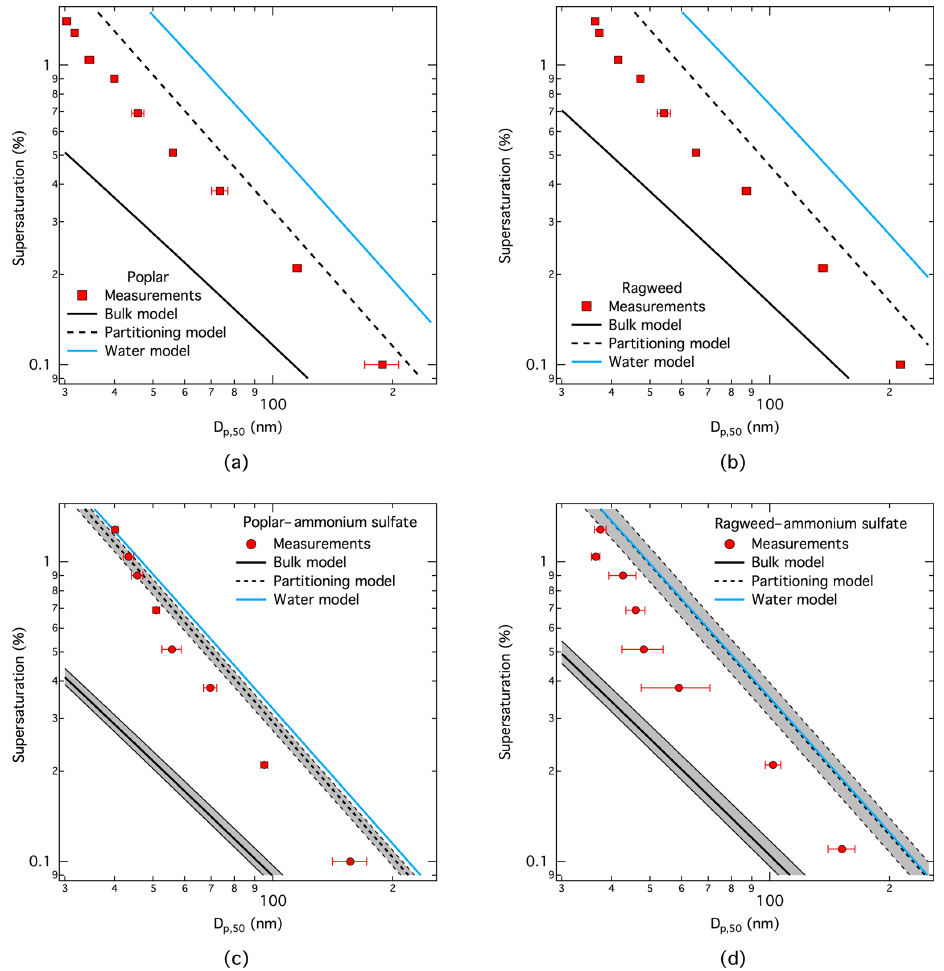
Figure 4. CCN activity modeled with the three different thermodynamic models (bulk, partitioning, and water) for particles compris- ing (a) pure poplar, (b) pure ragweed, (c) poplar and 20% by mass of ammonium sulfate, and (d) ragweed and 20% by mass of ammonium sulfate. For mixtures with ammonium sulfate, uncertainty ranges corresponding to a 10wt% uncertainty in dry particle composition are indicated for the bulk and partitioning models, which both include concentration-dependent surface